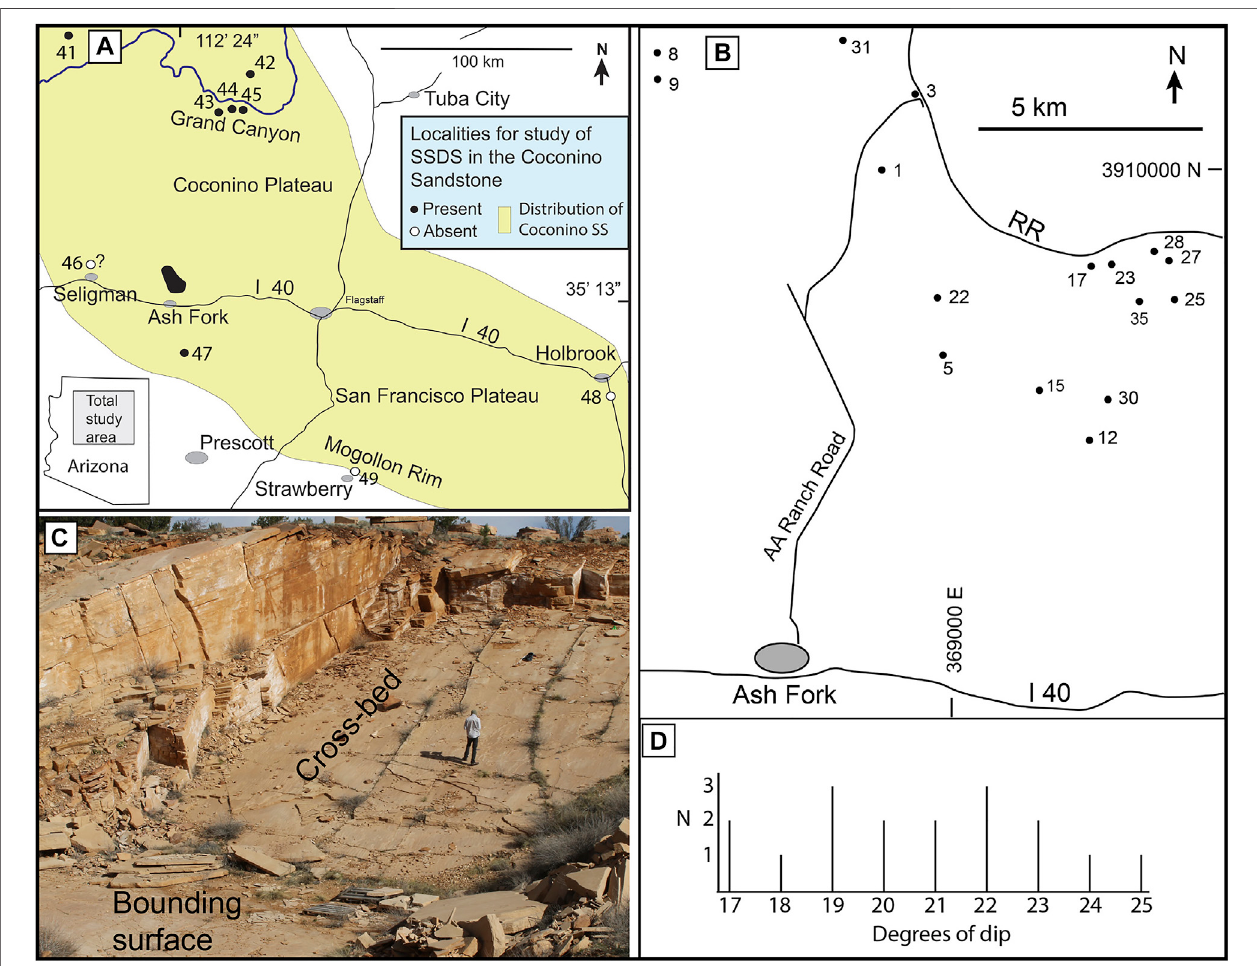
FIGURE 1 | (A) Map of the study region, showing locations where we searched for SSD, and which locations had SSDSs. The Coconino Sandstone extends for short distances beyond the area shown on this map. Grey ovals represent towns. Numbered study sites: 41 – 4.5 km N of Tuweep; 42 - North Kaibab Trail; 43 - Hermit Trail; 44 - Bright Angel Trail; 45 – New Hance Trail; 46 - 4 quarries, 5 km N of Seligman; 47 - Matterhorn; 48 - 5 Mile Wash, 8 km south of Holbrook; 49 – 2 km N of Strawberry. (B) MapofquarriesnearAshFork,withnumberedquarries. (C) AtypicalCoconinoSSquarrynearAshFork,Arizona.Heightofperson (cid:1) 1.8m(6ft). (D) Graph showing number (N) of quarry cross-bed surfaces with each degree of dip.